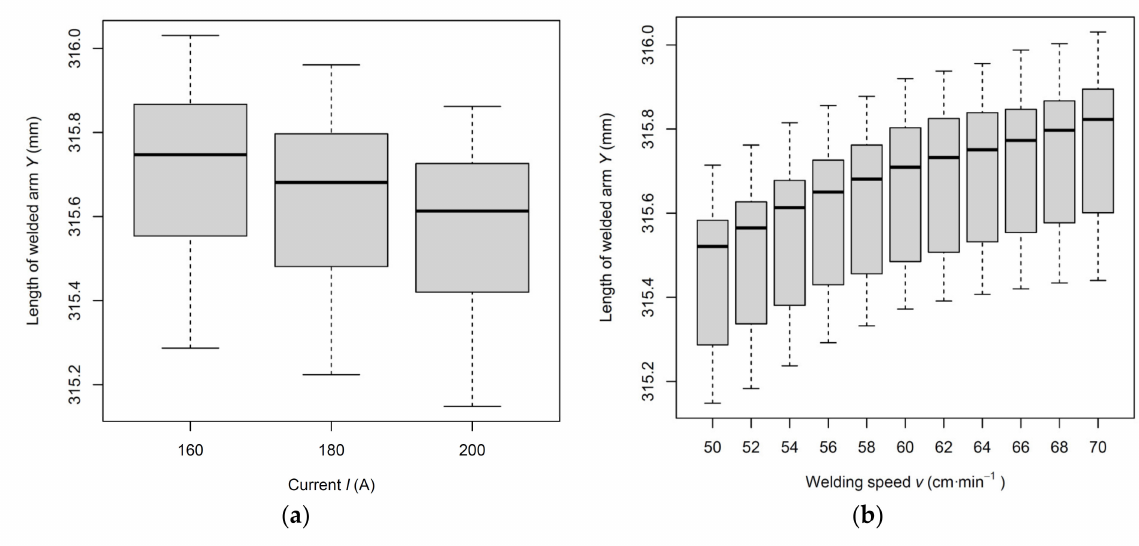
Figure 12. The influence of factor levels on the mean response Y value: ( a ) current I (A); ( b ) welding speed v (cm · min − 1